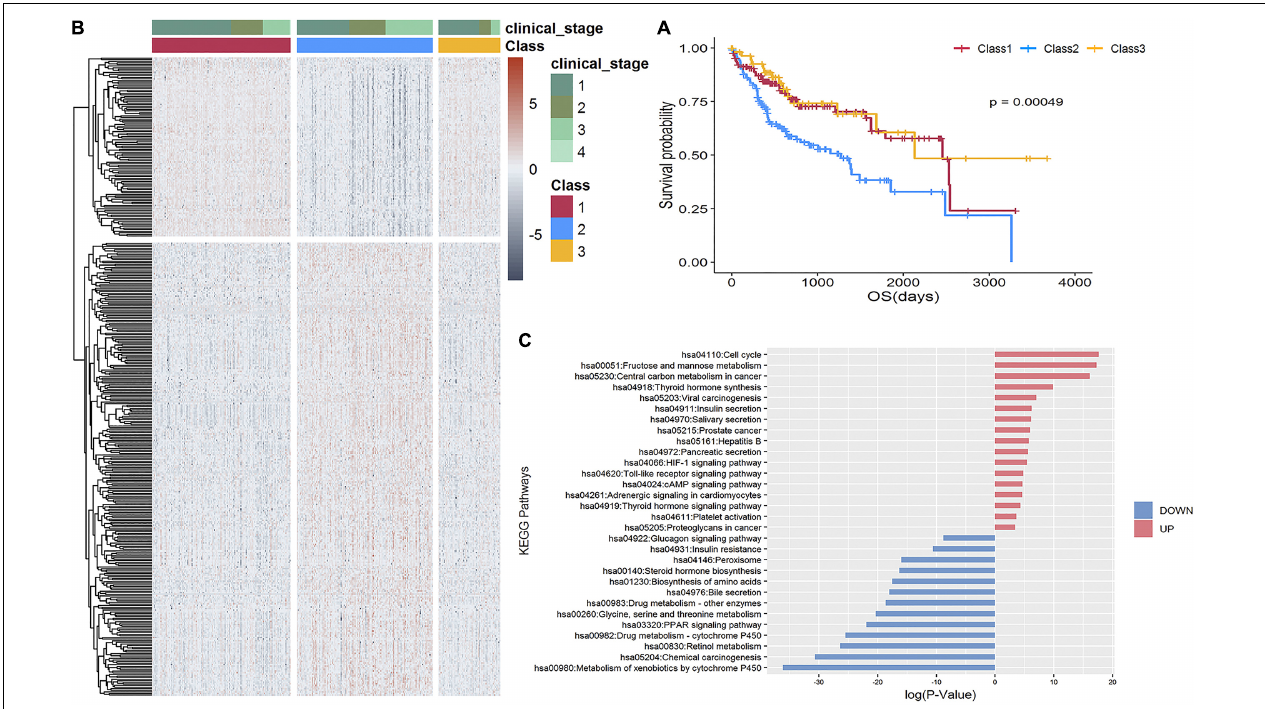
FIGURE 3 | Stratification of 315 TCGA-LIHC samples. (A) Kaplan-Meier curve shows the survival outcomes of Class 1 (red), Class 2 (blue), and Class 3 (yellow); the P -value is 0.00049, which is significant. (B) Heatmap of 399 differentially expressed genes revealed a distinguishable pattern between Class 2 and Class 1 and 3. Red color represents upregulated while dark gray represents downregulated. (C) Enrichment analysis of KEGG pathways of 287 upregulated and 112 downregulated genes,